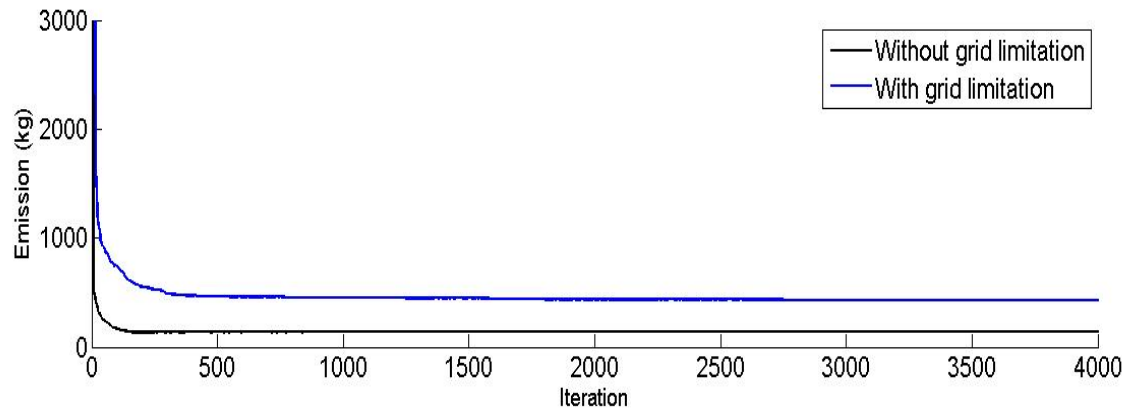
Figure 9. Comparison of pollution convergence with and without upstream transmission power limitations. Table 18. Power distribution between sources to reduce pollution without limiting power ex- change (total pollution: 136.58 kg).